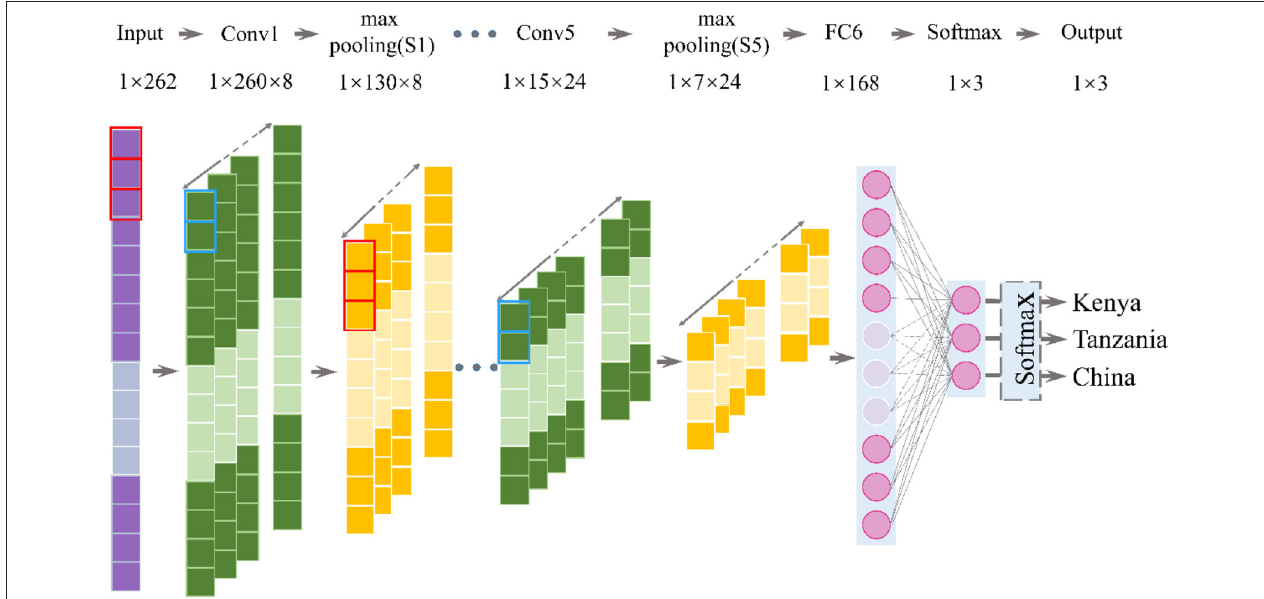
FIGURE 2 | The hierarchical construction of the convolutional neural network (CNN)-based classifier.